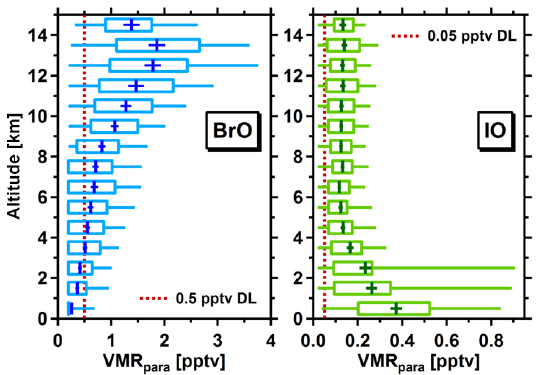
Figure 10. TORERO AMAX-DOAS BrO (left) and IO (right) VMR para data for the complete campaign. Plotted are 1km alti- tude means with their 95% confidence interval as uncertainty in darker colors, while the lighter colored whiskers denote 5, 25, 75 and 95